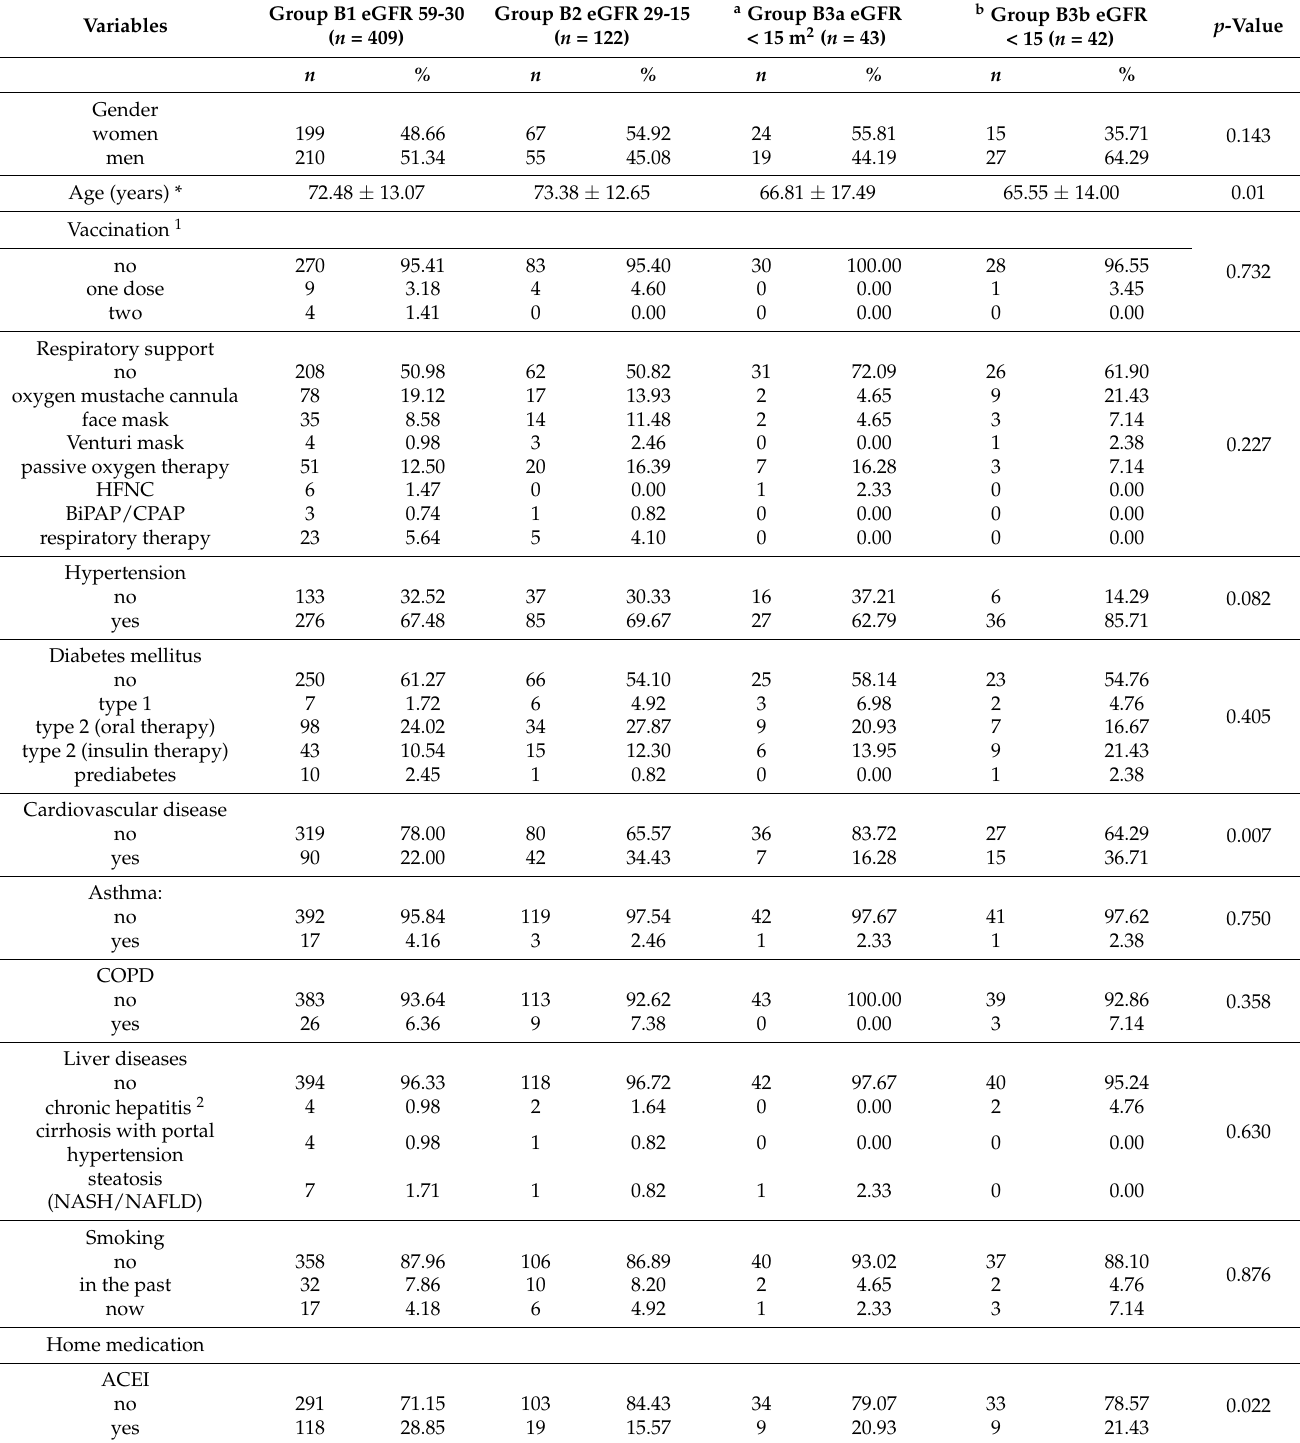
Table 3. Characteristics of COVID-19 patients with eGFR < 60 mL/min/1.73 m 2 (group B) divided into subgroups according to eGFR value at